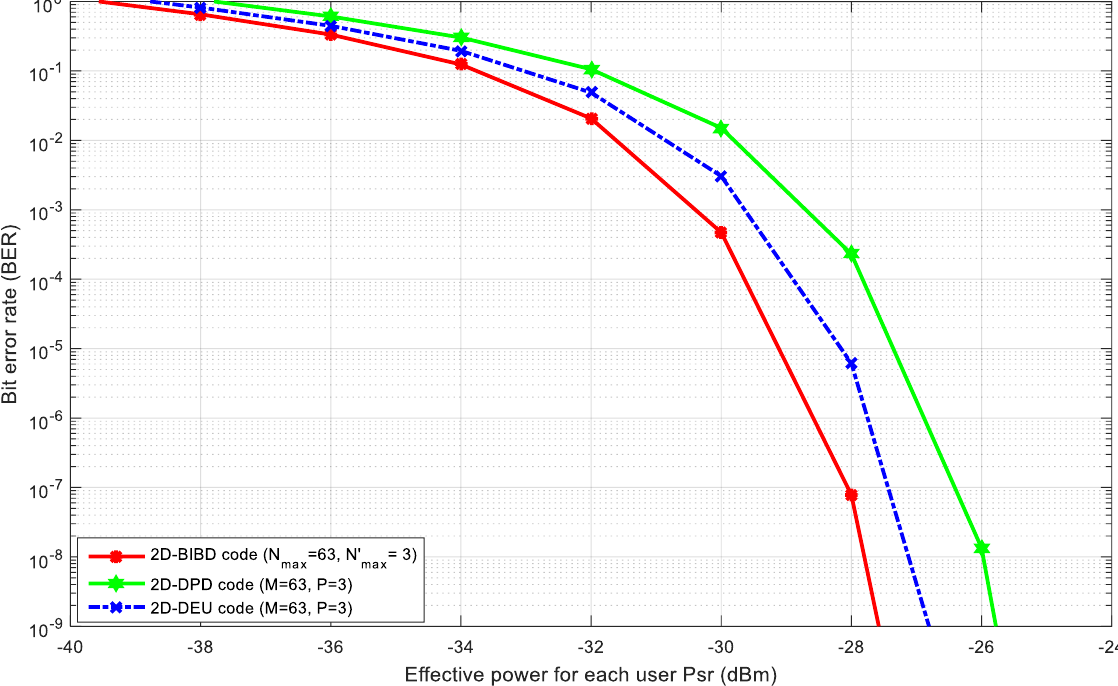
Figure 4. 2D-BIBD code’s performance in terms of BER and effective source power ( P sr ) at a data rate of 622 Mbps and the number of users K = 20.